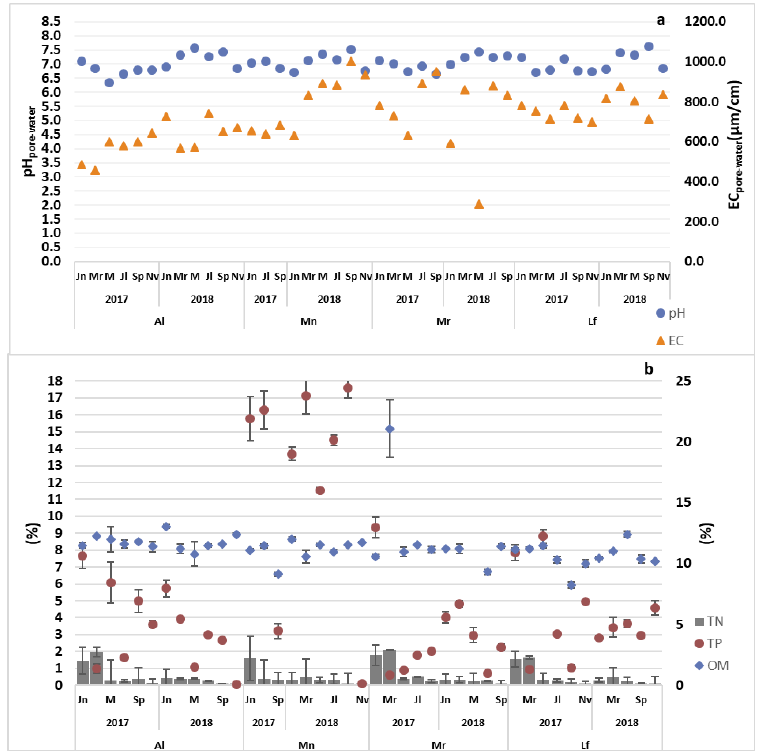
Figure 10. Dynamics of sediments’ chemical characteristics: ( a ). pH pore-water ; electric conductivity (EC pore-water ) and ( b ). organic matter (OM); total phosphorus (TP s ); total nitrogen (TN s ), values represented by mean ± standard deviation ( n = 3), in the different sampling locations (( Á lamos (Al), Montante (Mn), Mourão (Mr) and Lucefécit (Lf)).